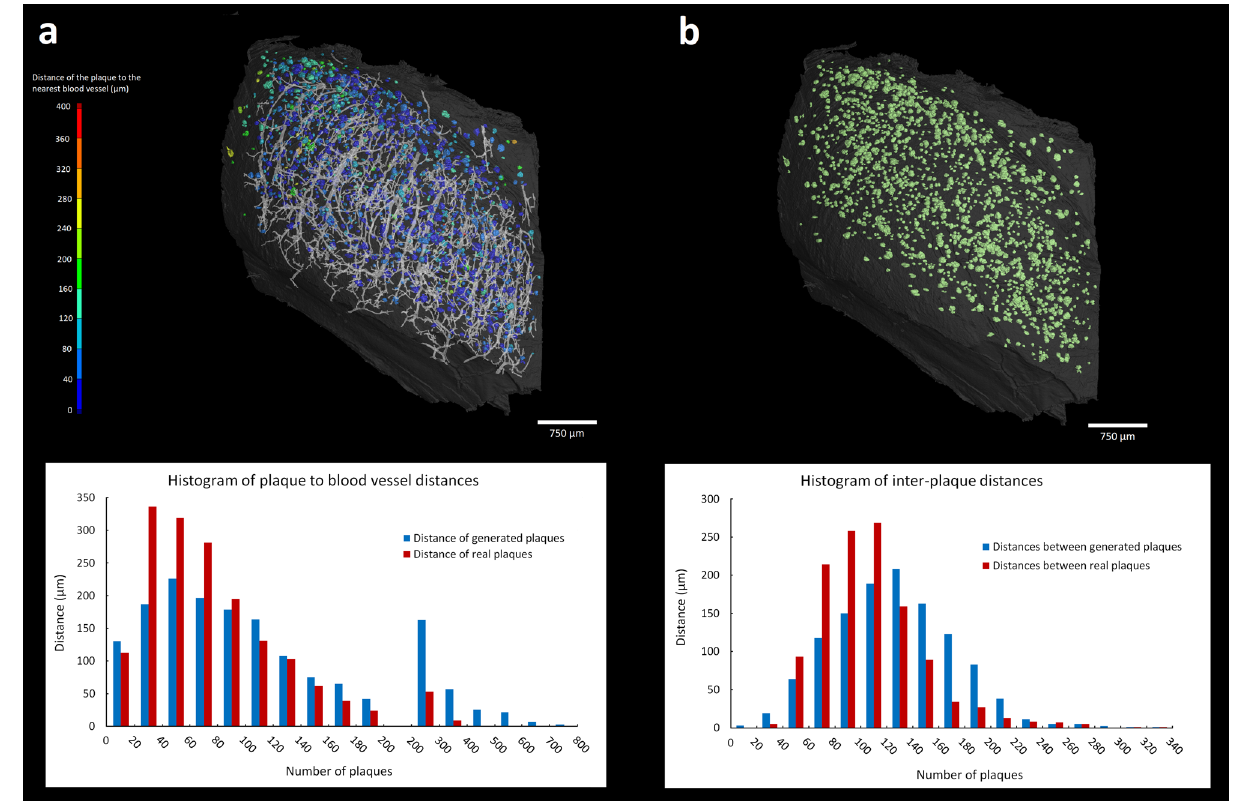
Figure 5. 3D quantitative analysis of the plaques distribution in hippocampus: Horizontal view of the hippocampus with color coded distances of individual plaques to the nearest blood vessel ( a ) and the corresponding histogram showing the distances to the nearest blood vessel of randomly generated (in blue) and the real (in red) plaques, respectively. Horizontal view of the hippocampus depicting the distribution of the plaques inside the hippocampus ( b ) and the corresponding histogram showing the distribution of randomly generated plaques (in blue), and the distribution of real plaques (in red) 41,42